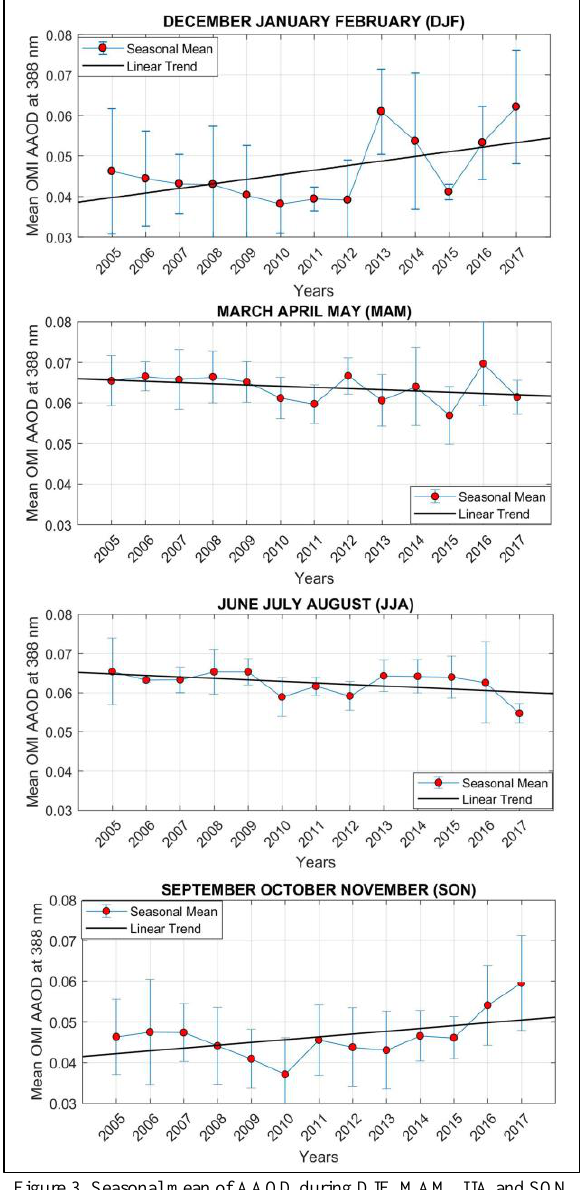
Figure 2. Methodology